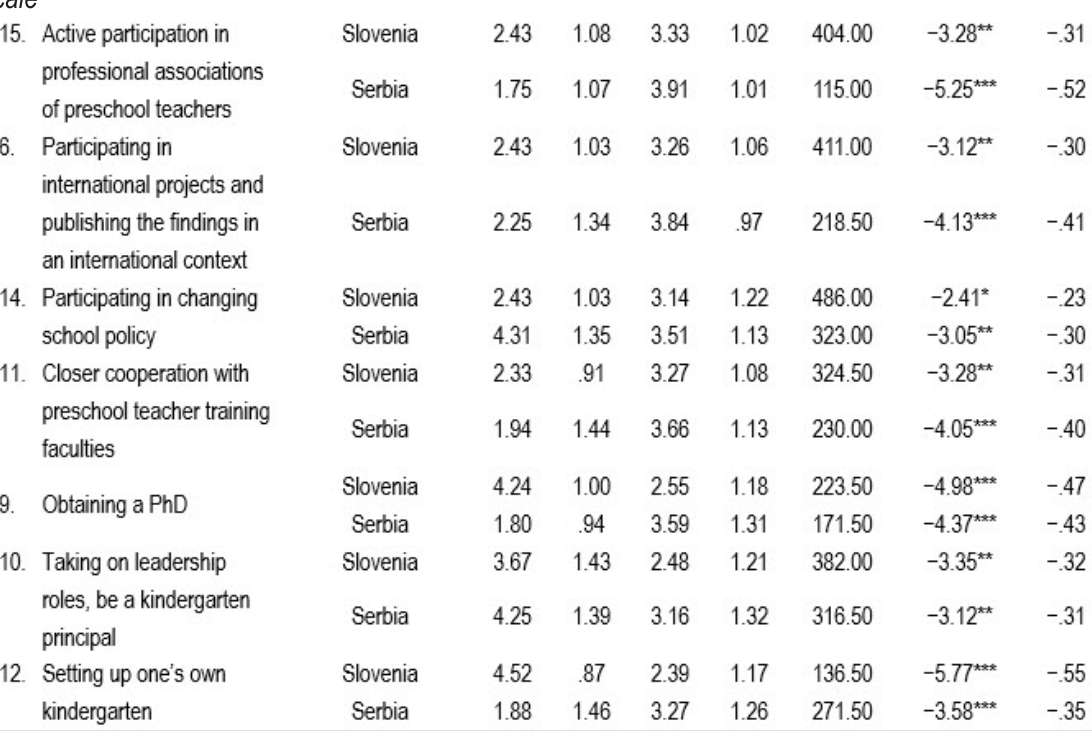
Table 8 (Continuation of the table from the previous page) Means, standard deviations, and Mann-Whitney test for individual items of the Career Expectations